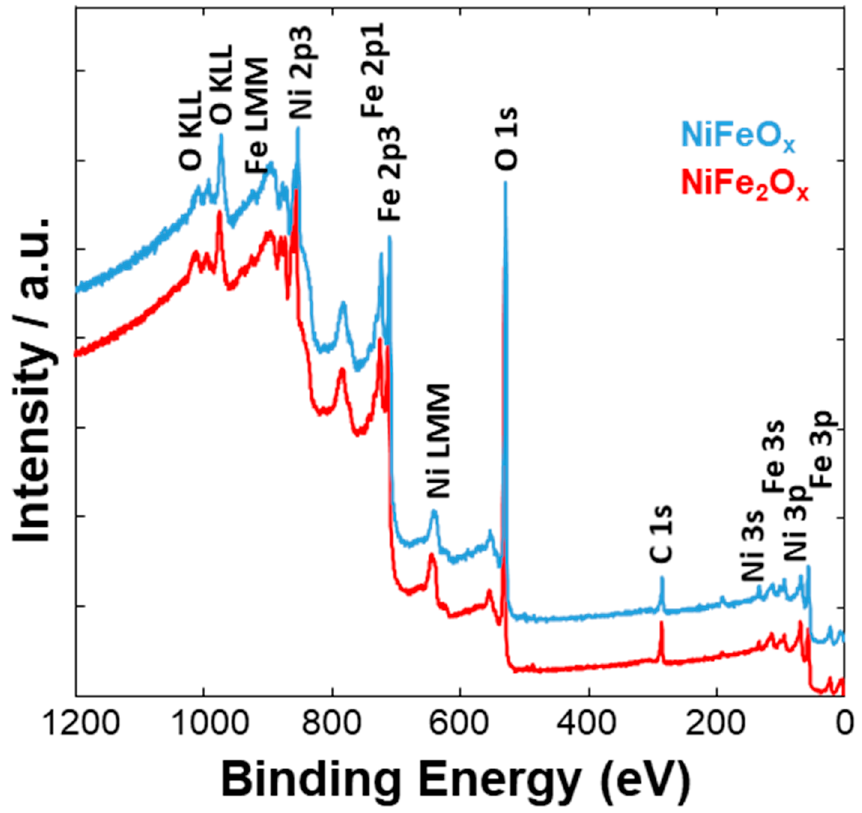
Figure 4. XPS survey analysis of the NiFe-oxide catalysts.